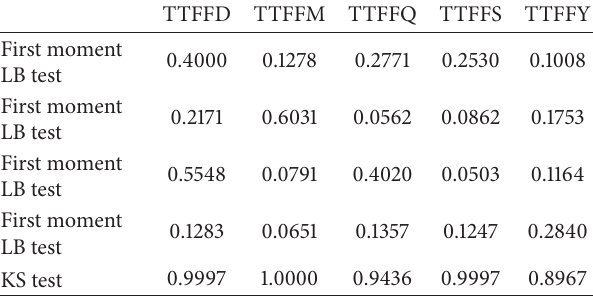
Table 4: Goodness-of-fit test for marginal